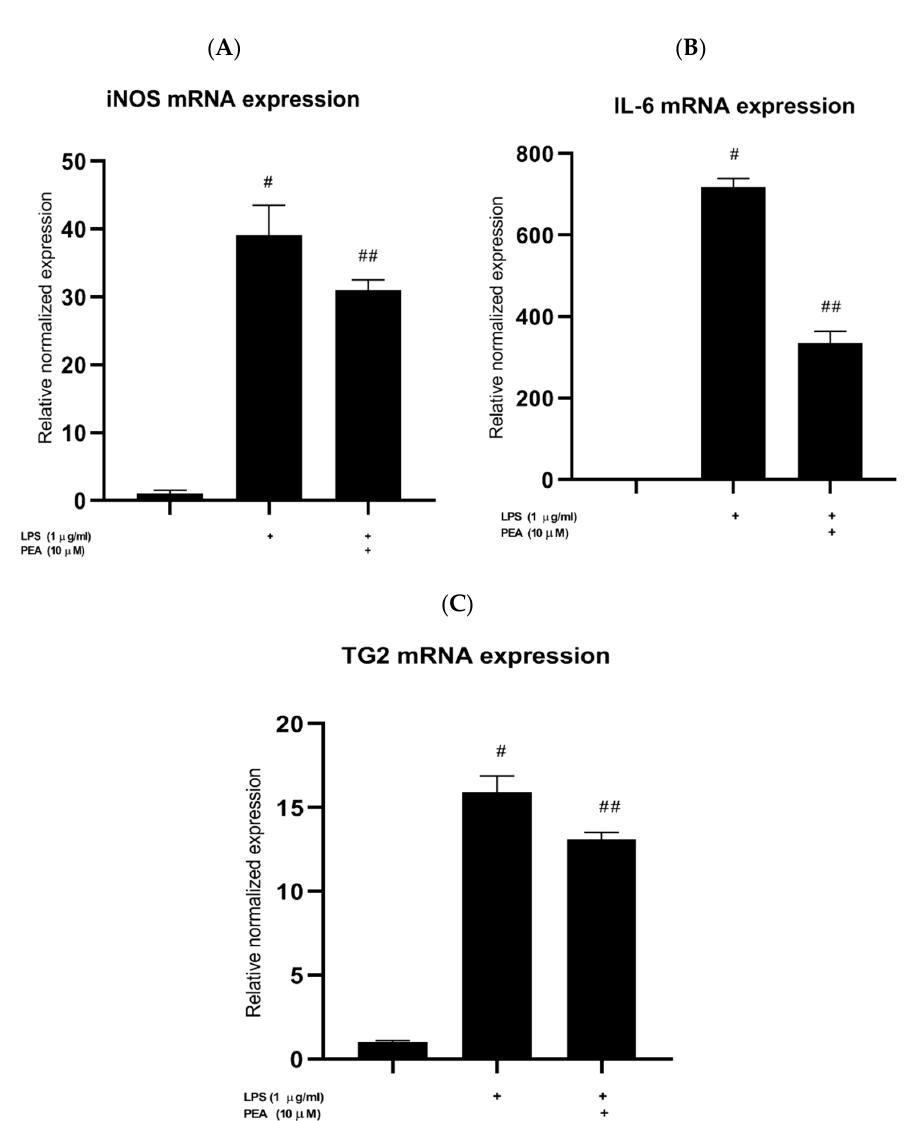
Figure 4. Real Time-PCR was performed to measure the mRNA expression. Murine primary microglial cells were treated with the indicated concentrations of PEA followed by treatment with 1 µ g/mL LPS for 24 h. Data are shown as the mean ± SD of three independent experiments. # p value < 0.05 compared with control group. ## p < 0.05 compared with LPS group.